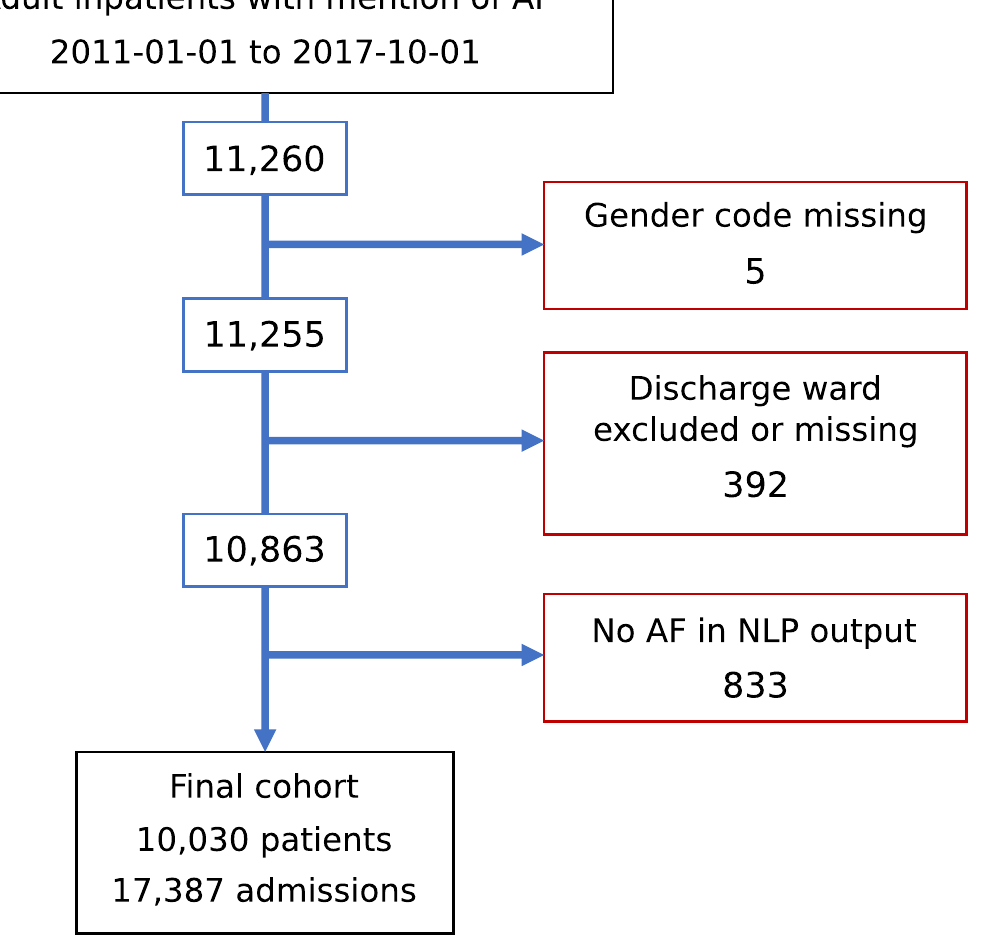
Fig 1. Derivation of the study cohort. AF = Atrial fibrillation, NLP = natural language